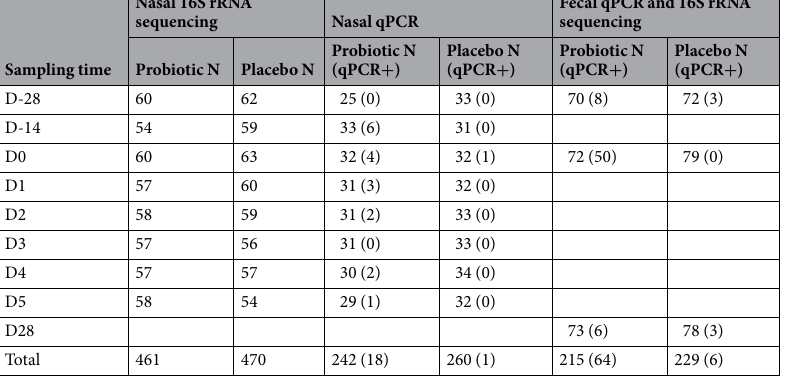
Bl-04 intervention and rhinovirus infection had minimal effect on nasal microbiota. The pres- ence of Bl-04 in the nasal cavity of 52 subjects was evaluated by qPCR (Table 1). All the samples in the placebo group tested negative for Bl-04 except for one D0 sample. In the probiotic group, Bl-04 was not detected at D-28, but was found after supplementation in < 18% of samples and during the infection in < 10% of the samples. By sequencing, genus Bifidobacterium was detected at a significantly greater abundance in the probiotic group after supplementation period at D0, however, after multiple testing correction the effect was non-significant (probiotic vs. placebo: 0.2217% vs. 0.0198%; P = 0.0034, FDR P = 0.169, Kruskal-Wallis test). No differences were detected in phylum- or genus level-taxa abundances between probiotic and placebo groups for any study day (data not shown, FDR P > 0.1). Neither the probiotic intervention nor rhinovirus infection had an effect on the alpha diver-